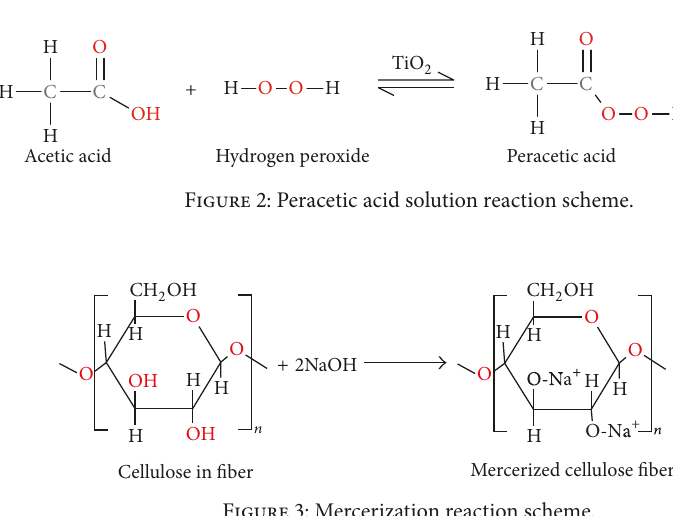
Figure 3: Mercerization reaction scheme.